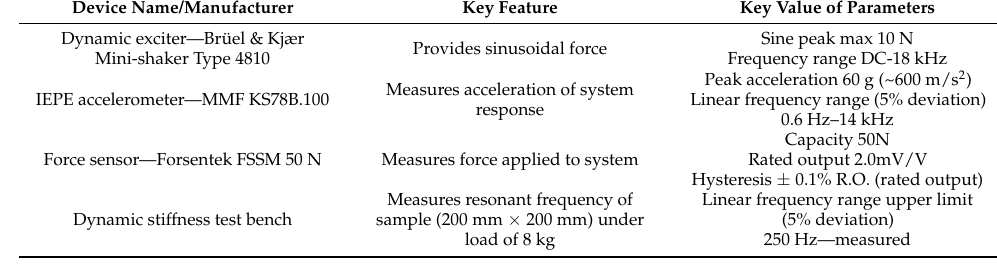
Table 2. Detailed characteristics of key components of dynamic stiffness machine.